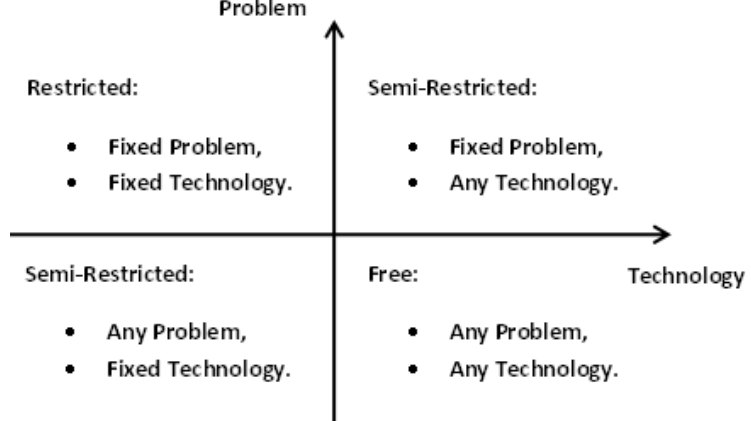
Fig. 1. Project handling